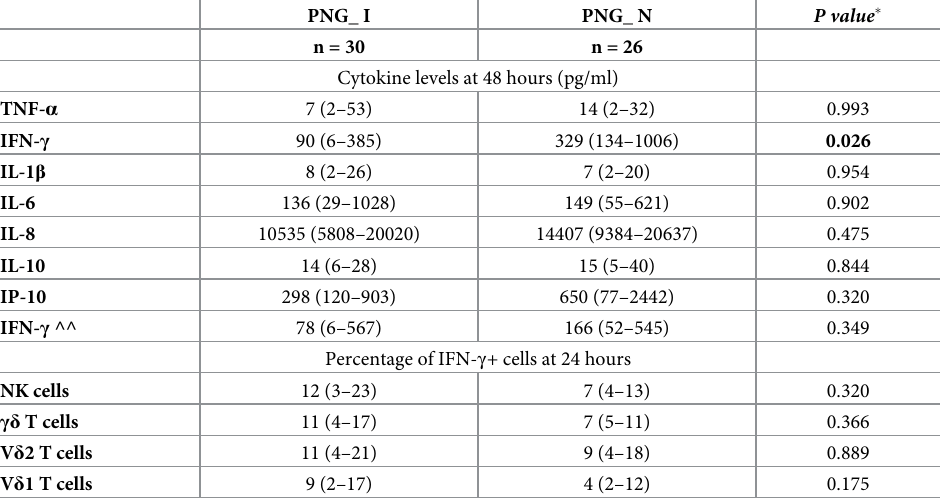
Table 2. Cytokine secretion and cellular responses to CS2 IE between malaria infected and non-infected women from PNG. PNG_ I PNG_